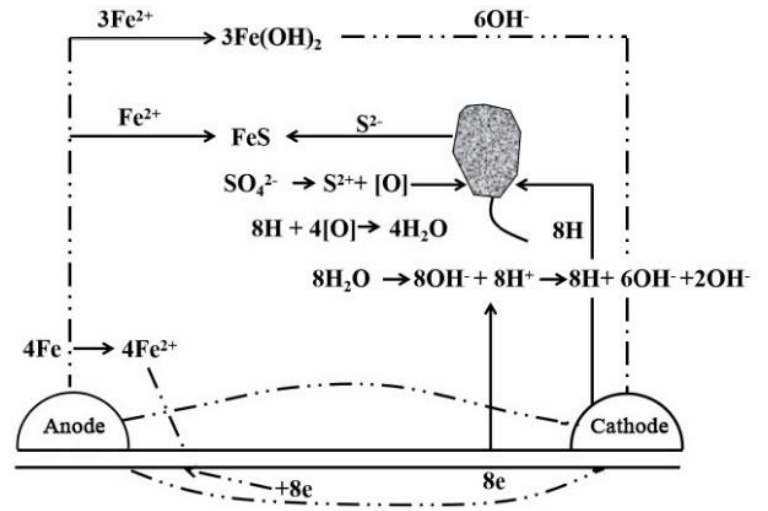
Figure 7. Sulfate reducing bacteria corrosion diagram.